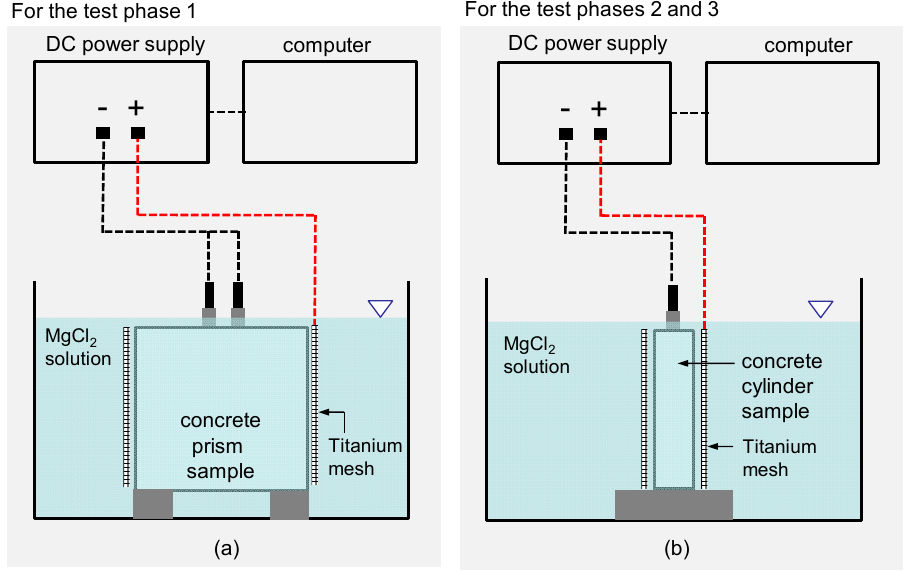
Figure 4. Illustration of the test setups of electrochemical deposition treatment (EDT) for: ( a ) concrete prism samples in test phase 1 and ( b ) concrete cylinder samples in test phases 2 and 3.